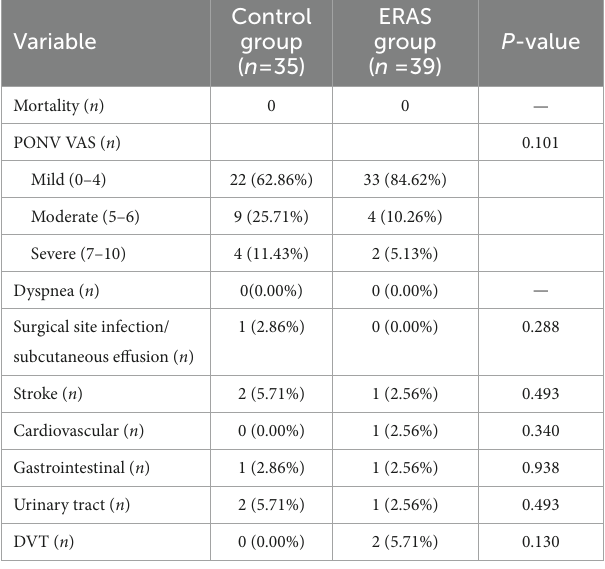
TABLE 5 Postoperative complications n (%).